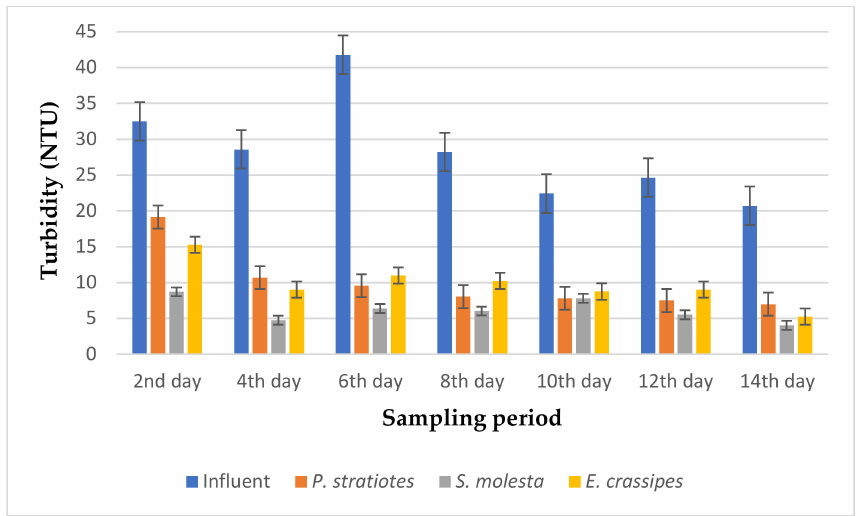
Figure 4. Bar plot of the average turbidity vs. the sampling period with a 12 h retention